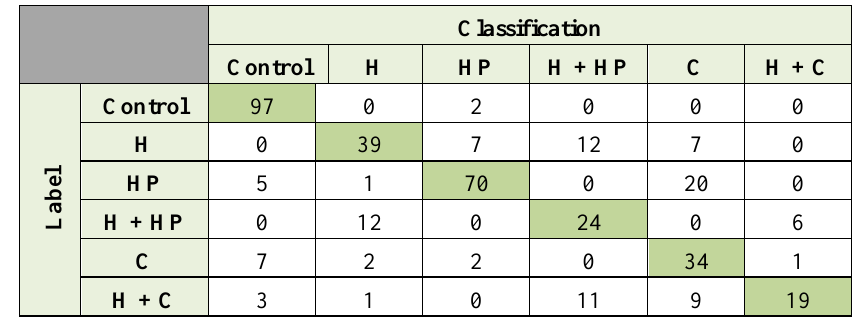
Table 5. Sample condition classification confusion matrix, for 3 month old age group. Accuracy 72.4% ( vs . chance accuracy 25.3%).